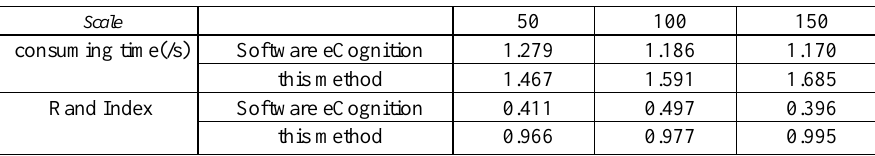
Table 1. The quantitative assessment of the segmentation results of analog